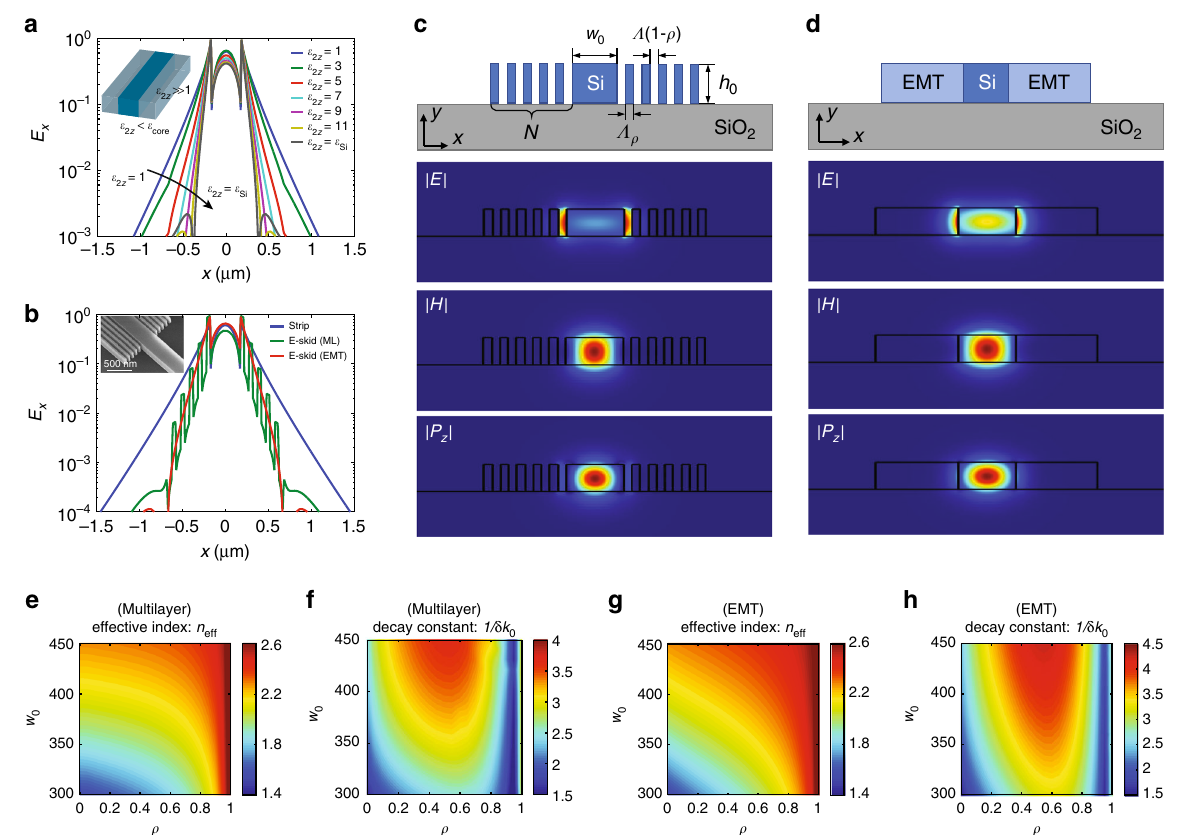
Fig. 3 On-chip extreme skin-depth (e-skid) waveguides. a Ideal on-chip e-skid waveguide; light is con fi ned by total internal refection inside the core and as the effective anisotropy of the multilayer metamaterial cladding is increased, evanescent waves of TE-like modes decay faster in the cladding in comparison with the fi eld in strip waveguides ( ε 2 z ¼ 1). Note that ε 2 x ¼ 1 for all cases. b The simulated electric fi eld pro fi le at the center of the e-skid waveguide with ¼ 1 : 85 and ε ¼ 6 : 8) (red) claddings, in comparison with a strip waveguide (blue). Inset shows the multilayer (green) and homogenized metamaterial ( ε 2 x 2 z SEM image of the fabricated e-skid to strip waveguide transition. c , d Schematic and fi eld pro fi les of c realistic e-skid waveguide with multilayer claddings ¼ k ′ = k ð Þ and g , h normalized decay constants ( k ′′ = k ¼ 1 = δ k and d its equivalent model with EMT claddings. e , f Effective refractive indices n ) of the z x 0 0 0 eff e-skid waveguide as functions of the core width w 0 and fi lling fraction ρ : with e , g multilayer and f , h EMT claddings, respectively. Geometric parameters are h 0 = 220 nm, w 0 = 350 nm, Λ = 100 nm, ρ = 0.5, and N = 5, unless otherwise indicated. The free space wavelength is λ = 1550 nm. Simulations con fi rm that the cladding achieves effective all-dielectric anisotropy as well as the increased decay constant of evanescent waves outside the